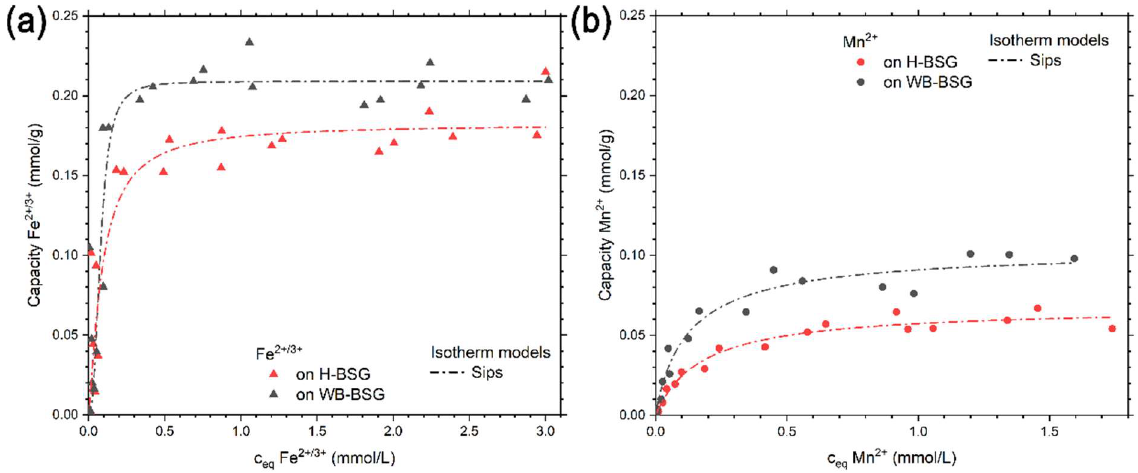
Figure 8. Adsorption isotherms for ( a ) Fe 2+/3+ and ( b ) Mn 2+ onto H-BSG and WB-BSG, obtained from batch experiments with constant BSG dosage (3.33 g/L) and varying initial concentration of FeSO 4 or MnSO 4 for 24 h at r.t. Fitted Sips isotherm model is presented as dash-dotted line, curves of other fitted models are given in Figures S9 and S10.